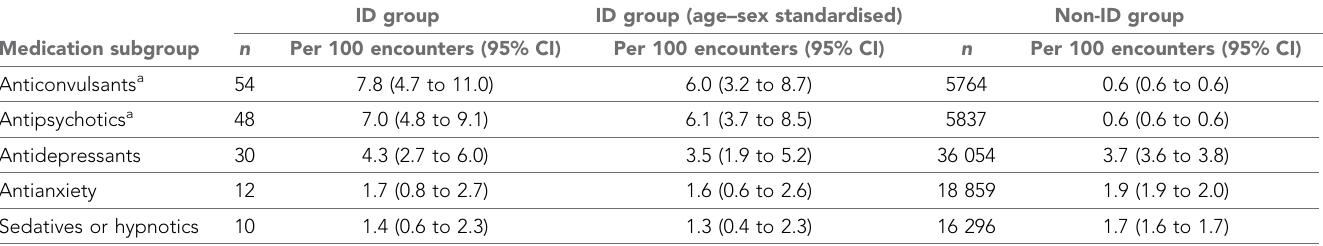
Table 3. Comparison between the ID (age–sex standardised) and non-ID groups of selected nervous system medication subgroups: rates per 100